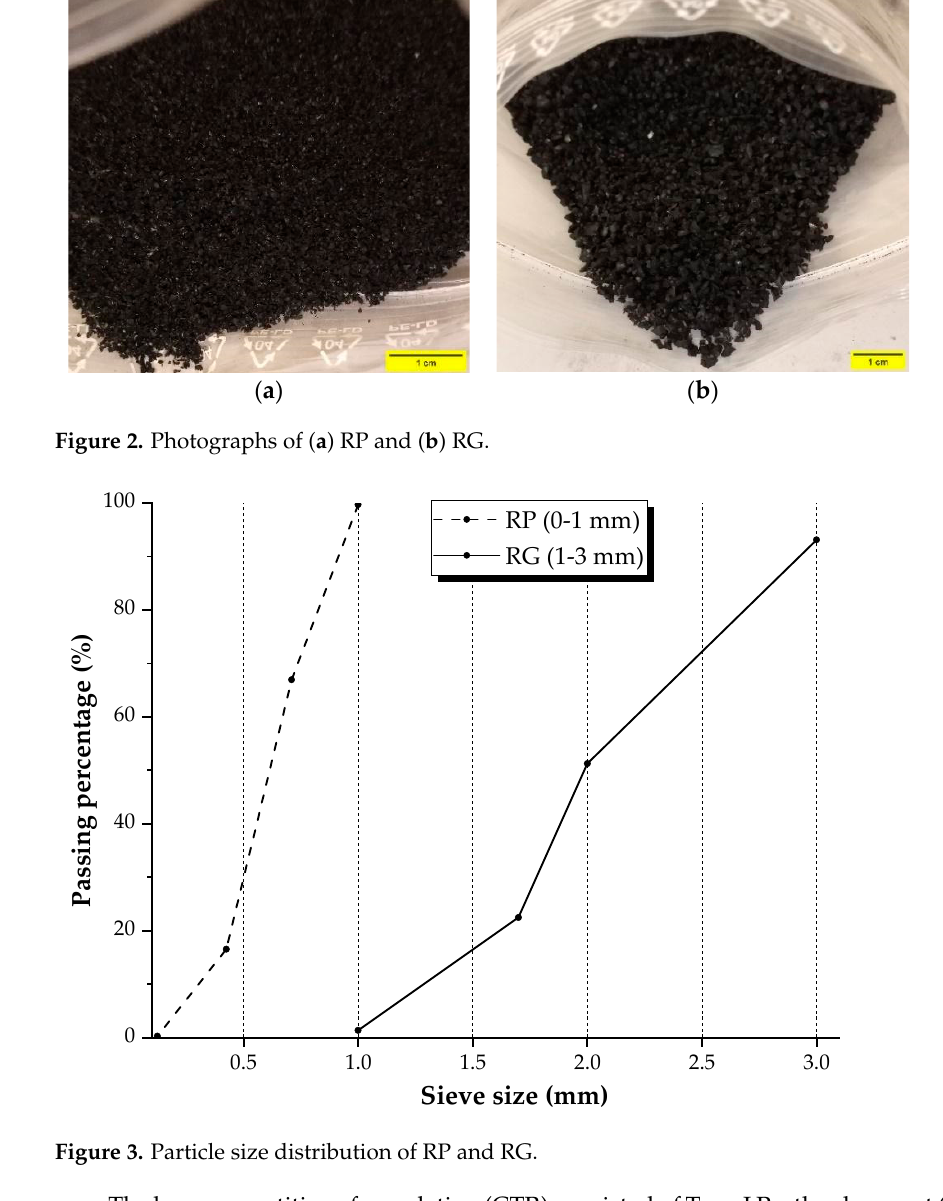
Figure 3. Particle size distribution of RP and RG.